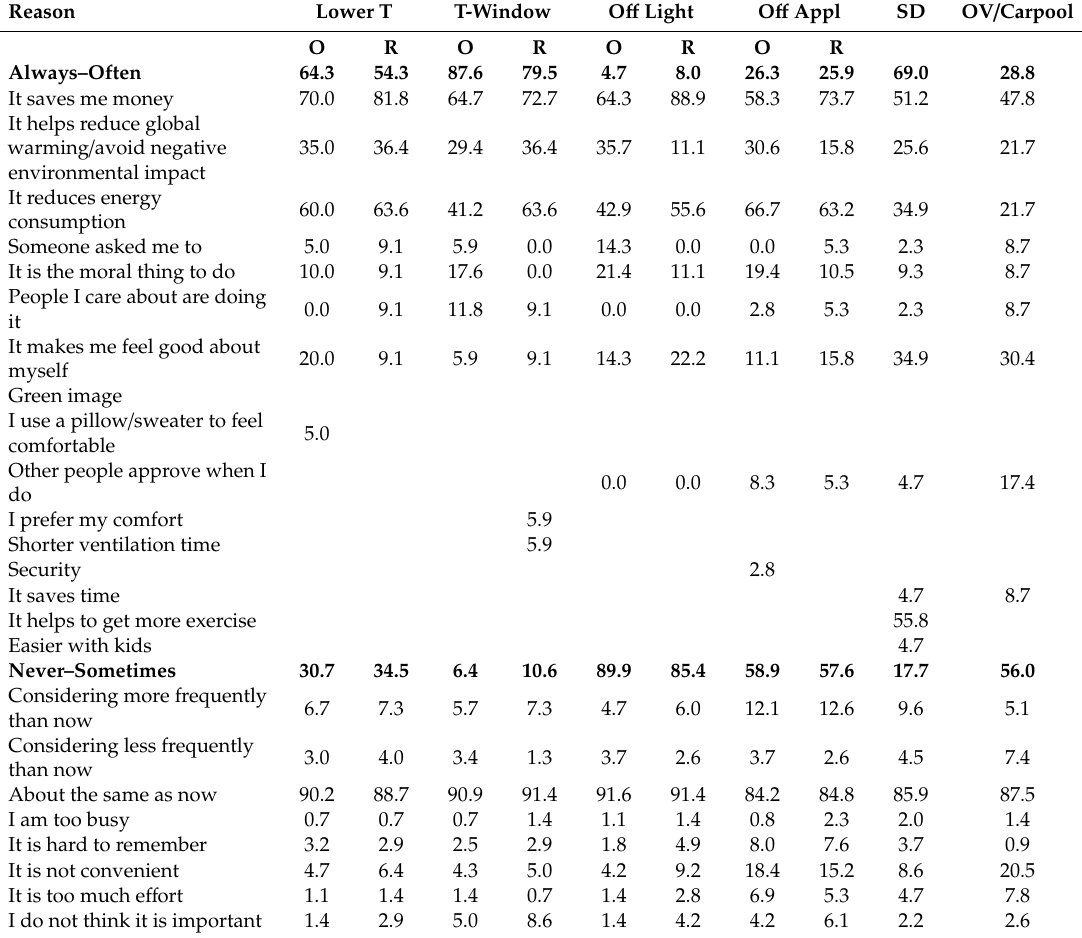
Table 4. Behavioral energy saving